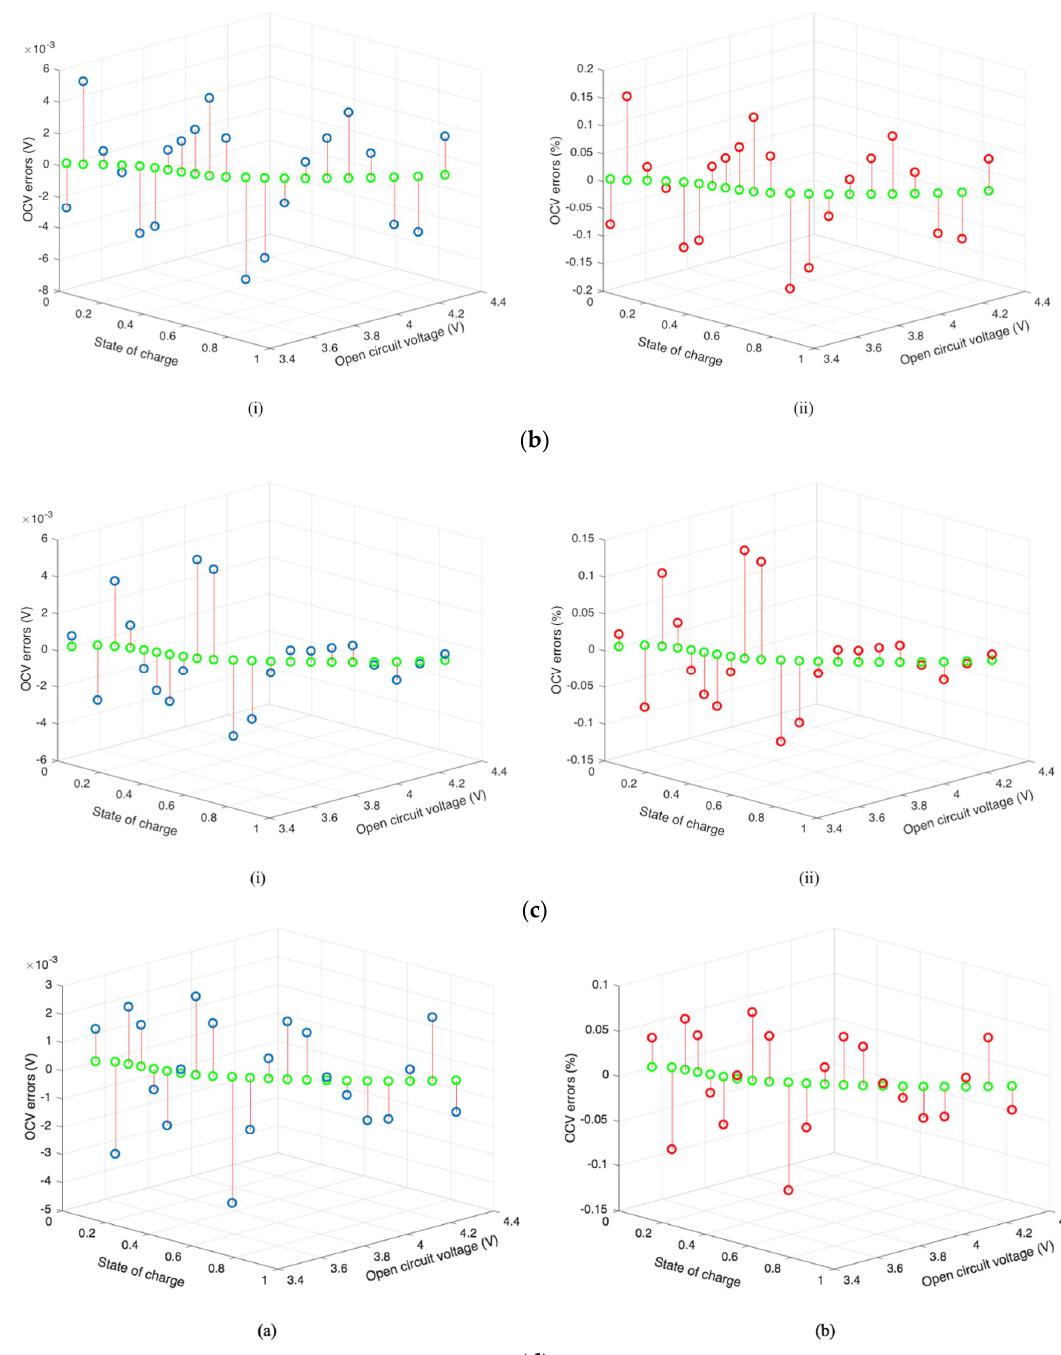
Figure7. OCV‐SOC error by six order polynomial fitting. ( a ) 45 °C; ( b ) 25 °C; ( c ) 0 °C; ( d ) –20 °C. Figure 7. OCV-SOC error by six order polynomial fitting. ( a ) 45 ◦ C; ( b ) 25 ◦ C; ( c ) 0 ◦ C; ( d ) − 20 ◦